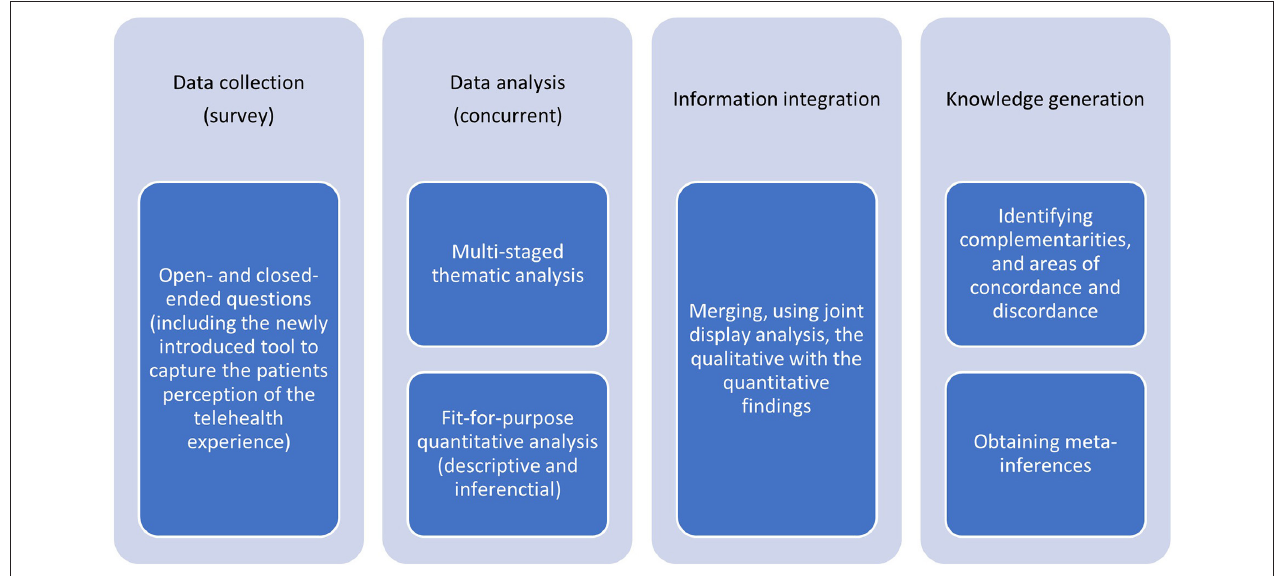
FIGURE 1 | Four sequential stages of the convergent mixed methods research design adapted for this study.